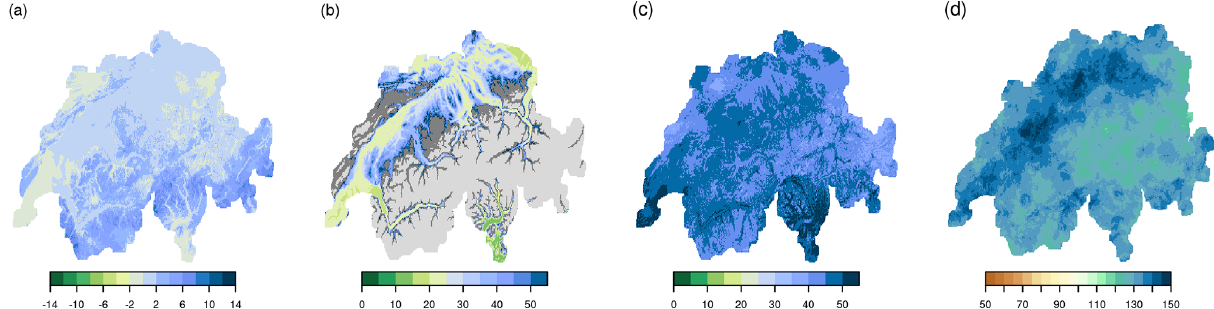
Figure A5. (a) Anomaly of the number of days with snowfall for April 1816. (b) Anomaly in days for the year 1816 when the threshold of 1000 GDDs was reached. Light-grey areas denote values where no climatology of a 1000 GDD threshold was calculated because the threshold was reached in less than 75% of the years between 1763 and 1812. Dark grey denotes areas where the threshold of 1000 GDDs was not reached in the year 1816. (c) Anomaly of the number of cold days (days below the 20th percentile of daily mean temperature) for April to September 1816. (d) Wet-day anomaly in percentage for April to September 1816. For comparison with the summer of 1770, all anomalies are calculated with respect to the 1763 to 1812 climatology, which does not include the year 1816. Note that the colour scales are different from Fig.